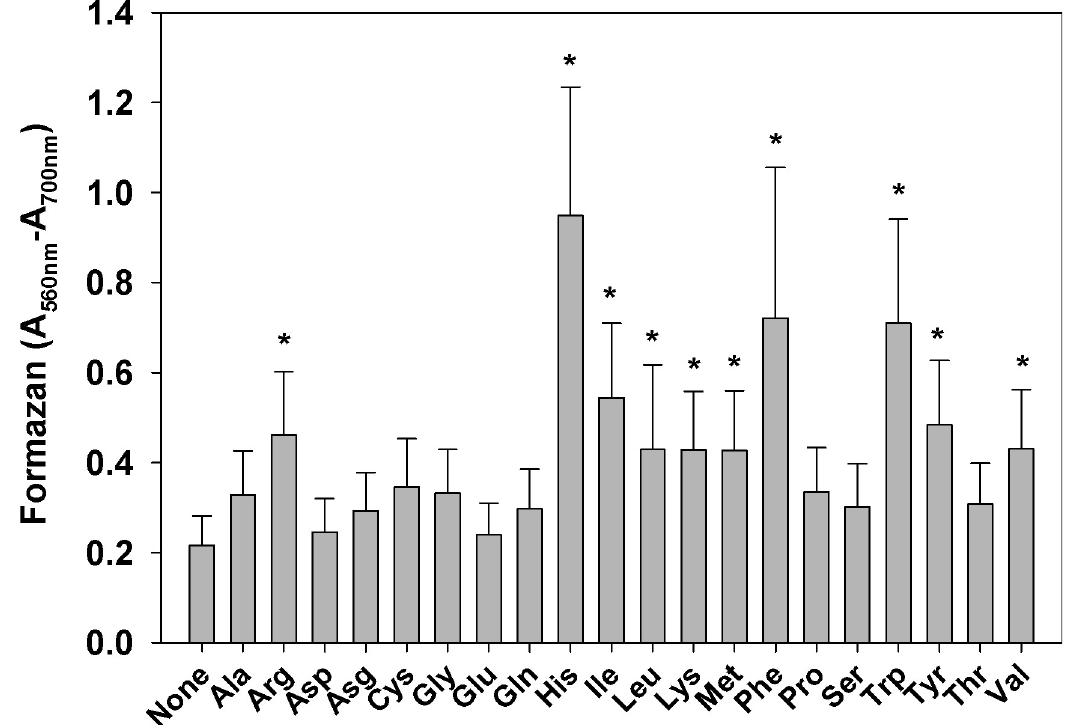
Fig 2. Effect of amino acids on reduction of MTT to formazan by E . coli . Mid-log LB culture was washed and resuspended in PBS + glucose to OD 600 = 0.5. One hundred μ l aliquots were dispensed in triplicate wells of a 96-well plate, amino acid sterile solutions were added to a final concentration of 5.0 mM, and the MTT test was performed. Controls, containing PBS-glucose and the respective amino acid, but not E . coli , were run in parallel. The experiment was repeated three times. Results are presented as mean ± SD. � Indicates statistically significant difference compared to controls containing E . coli in PBS/glucose but not amino acids (p <